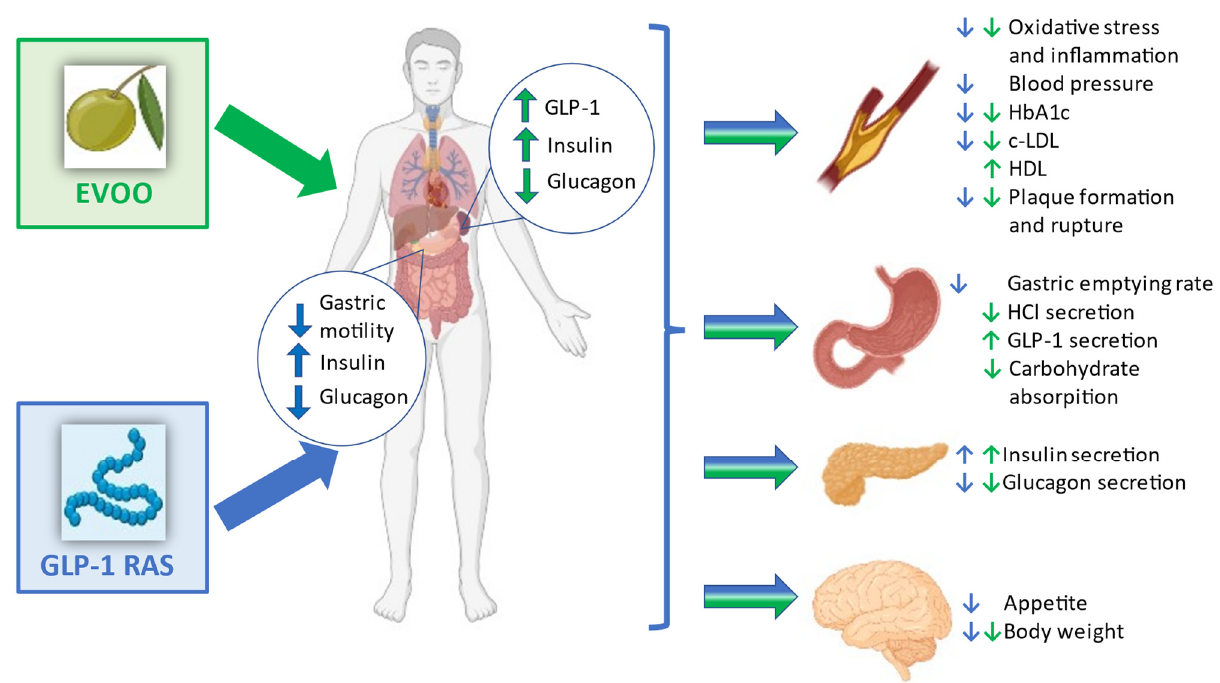
Figure 1. EVOO and GLP-1 RA actions on gastric and pancreatic functions and their possible synergistic effects on glycaemic control and cardiovascular risk. The green arrows symbolize EVOO actions, the light blue, GLP-1 RA actions. Table 1. Features of the studies published on EVOO and MedDiet beneficial